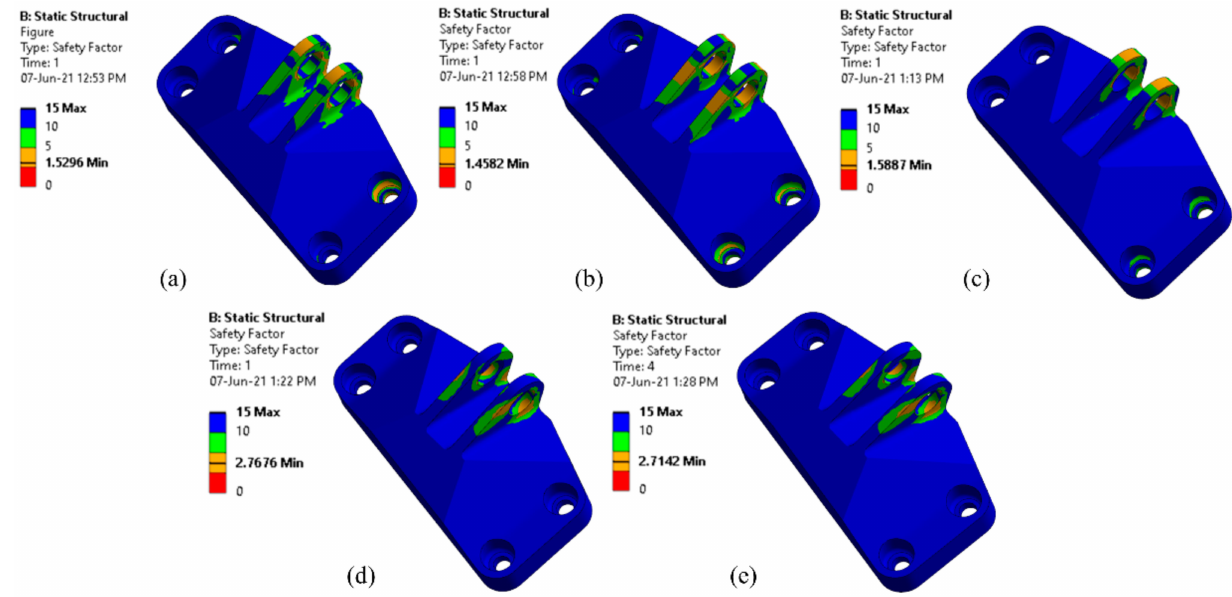
Figure 6. The FEA of the original design in each load case and at all load cases: ( a ) LC1, ( b ) LC2, ( c ) LC3, ( d ) LC4, and ( e )